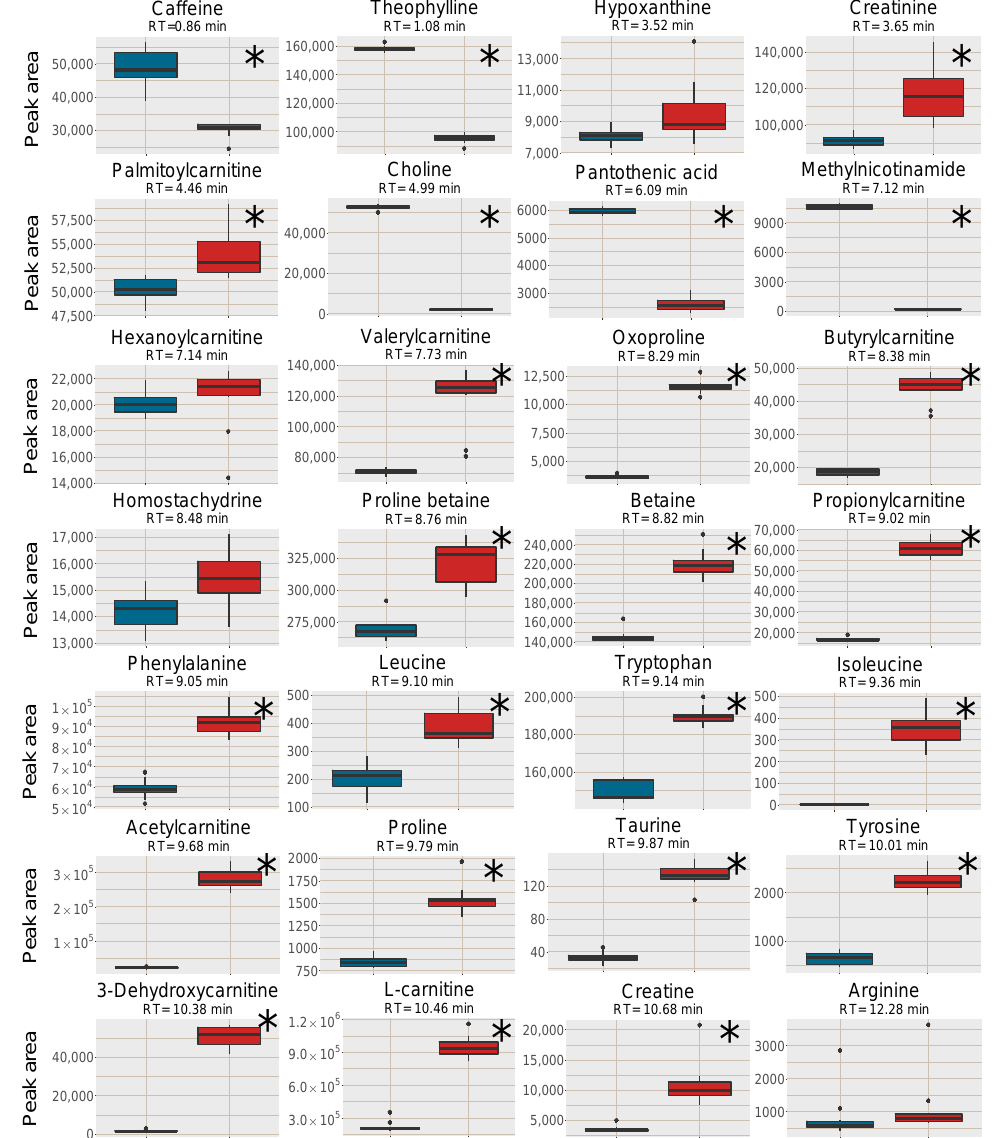
Figure 2. Box plots of the peak area of [M+H] + (or [M ] + where applicable) of all investigated analytes in the plasma samples, red box=SPE MCX, blue box = PPT. The outer edges of the boxes represent the first and third quartiles respectively while the middle line represent the median and outliers are denoted by dots in the plots. Analytes with statistically different peak area ( p < 0.05 in a unpaired t -test with bonferroni correction applied) between the two sample treatments are marked with a * in the top right corner of each individual box-plot.